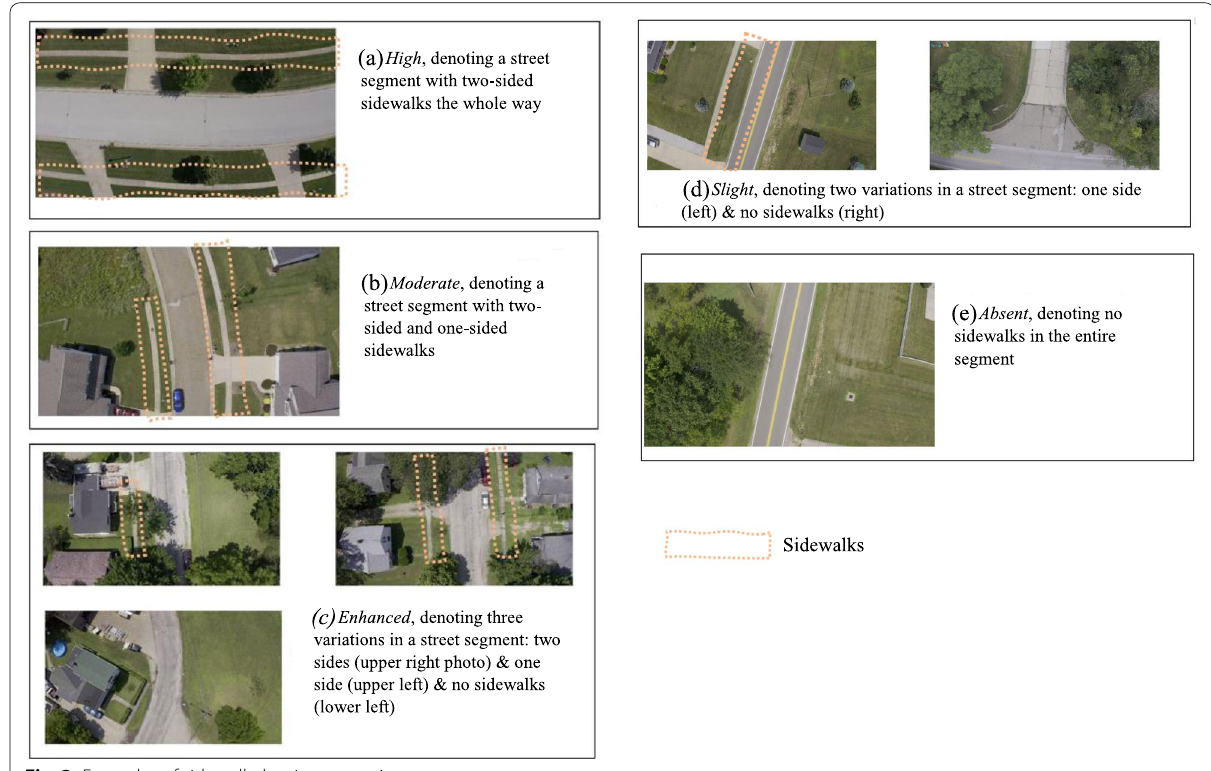
Fig. 3 Examples of sidewalk density